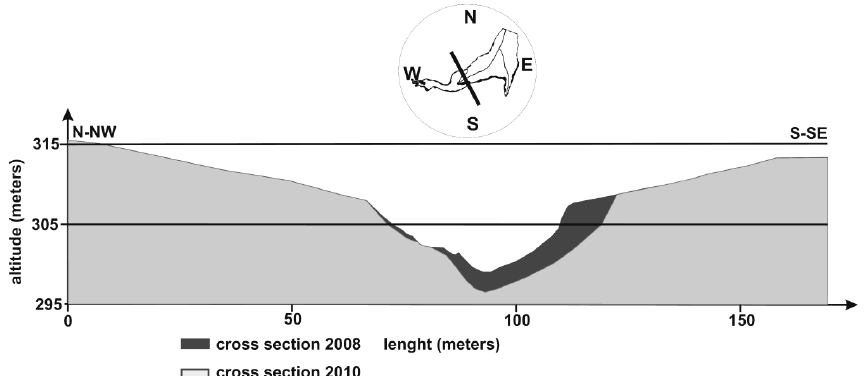
Fig. 14. Cross-section upstream of the gullies in the main high erosion activity